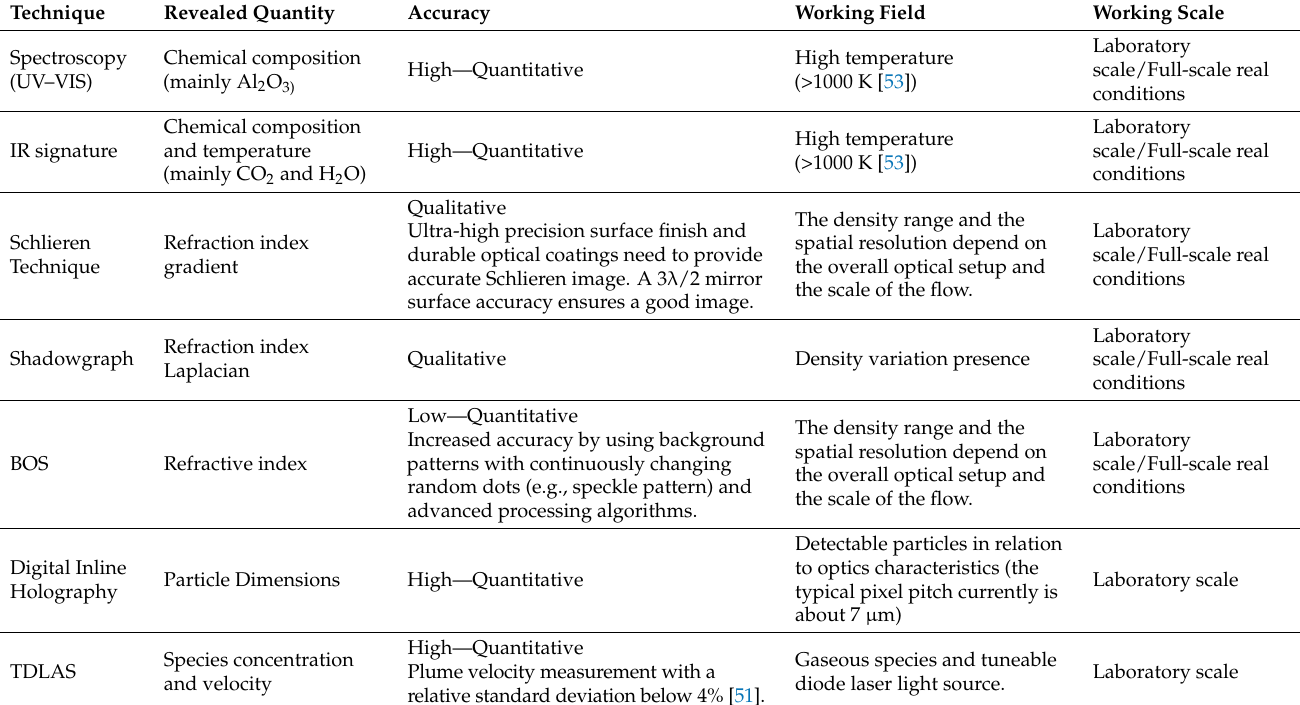
Table 1. Experimental techniques for SRM plume characterization: